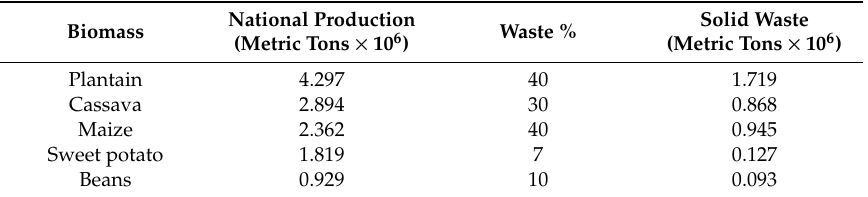
Table 8. Top five reported crops grown in Uganda with their waste % and resulting waste from crop available for energy use.